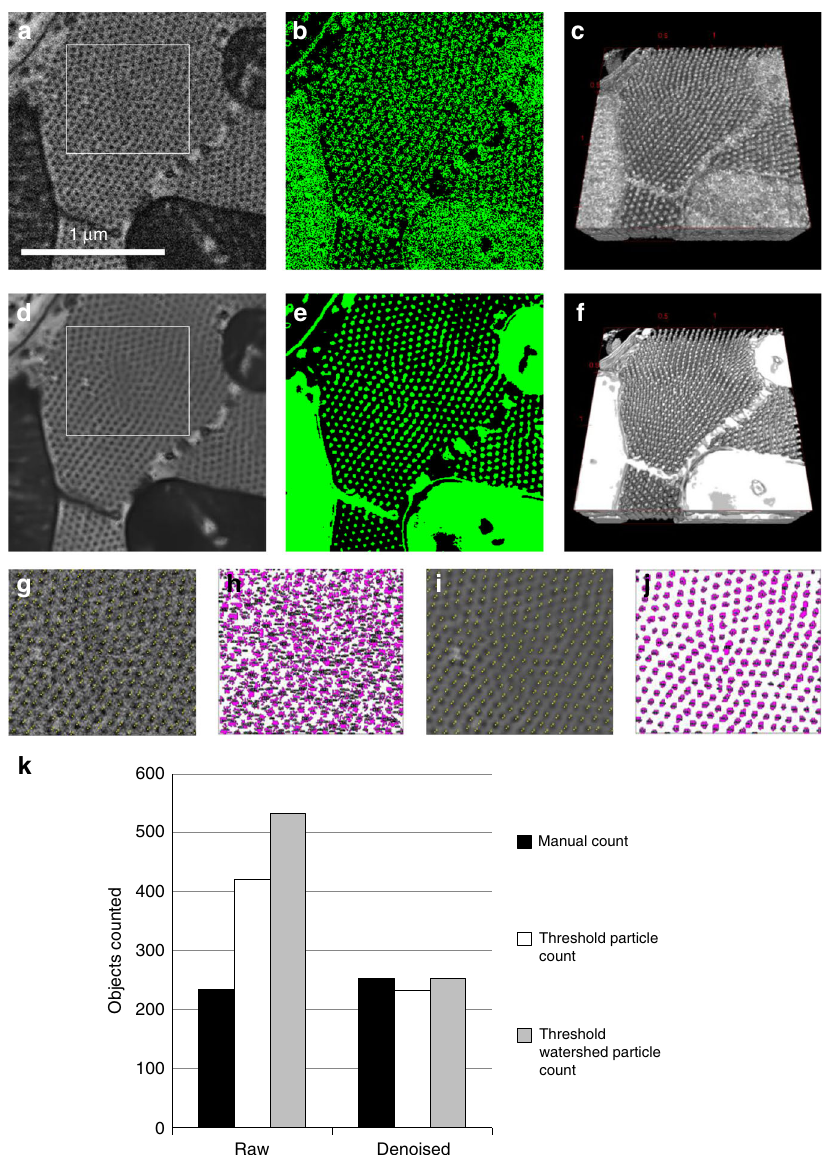
Fig. 6 Denoising in fl uence on sarcomere segmentation and counting in mouse heart tissue FIB-SEM data. A 3D ROI from a FIB-SEM data set, acquired at isotropic 5-nm resolution, from mouse heart tissue was used for denoising. a An XY view of 330 × 300 pixels of the raw image. b The image was used for creating a mask (in green) by intensity thresholding. c This mask was used for 3D rendering with the ImageJ 3D Viewer. d The data were denoised with DenoisEM, using the NLM algorithm, and e , f segmented by thresholding. g The ROI indicated in panel ( a ) was used for manual counting of sarcomeres with the ImageJ Cell Counter Plugin. h Each item counted is indicated with a magenta dot. Panels ( i ) and ( j ) show the counting results on the denoised data. k A graph showing the number of sarcomeres counted, either manual by three different individuals or by the ImageJ Analyse Particles tool on a thresholded image, with or without comparison for bilateral fi ltering 41 , anisotropic diffusion 38 , BLS- GSM 14 , and nonlocal means denoising 16 (results of the remaining methods can be found in the Supplementary Fig. 13). The results show that the Quasar implementations are one to two orders of magnitude faster than the classical CPU-based implementations.